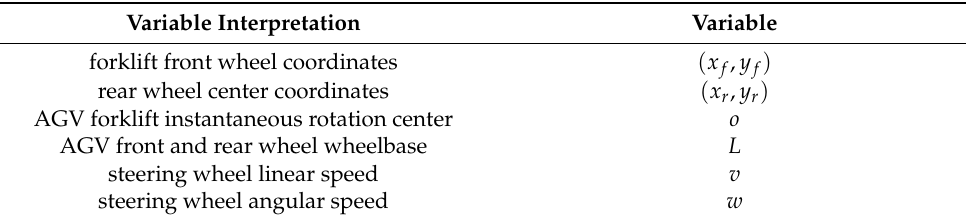
Table A1. Summary of variable comparison